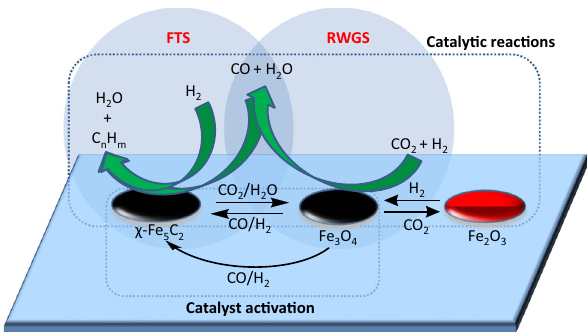
Fig. 5 Reaction scheme for CO 2 hydrogenation to jet fuel range hydrocarbons. The CO 2 hydrogenation to jet fuel range hydrocarbons process through a Tandem Mechanism in which the Reverse-Water Gas Shift reaction (RWGS) and Fischer-Tropsch synthesis (FTS) reaction are catalysed by Fe 3 O 4 and χ -Fe 5 C 2